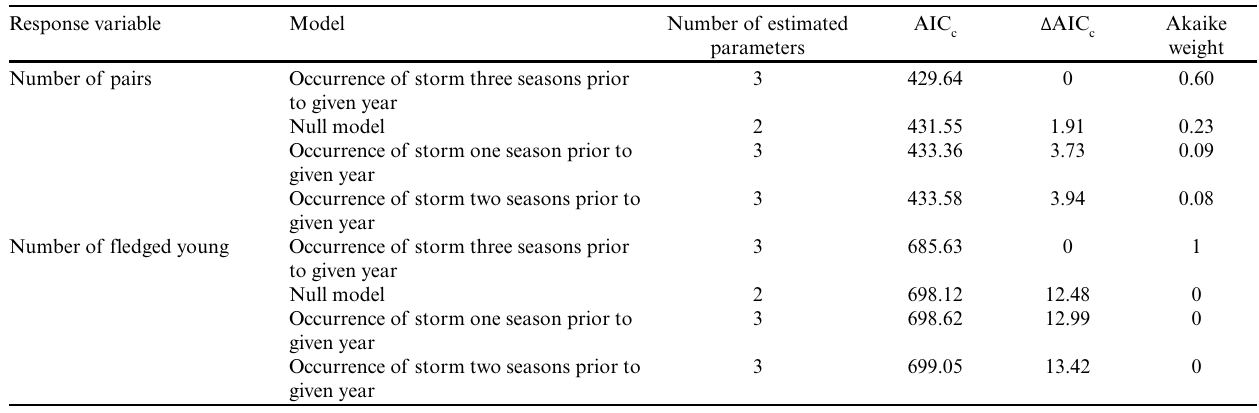
Table 4 . Model selection results based on second-order Akaike information criterion (AIC melodus melodus ) pairs and fledged young in five southeastern New Brunswick, Canada, sites between 1986 and 2012. Note that Δ AIC measures the difference in AIC between any model and the top-ranked model, whereas the Akaike weight is the probability that a c given model is the most parsimonious.